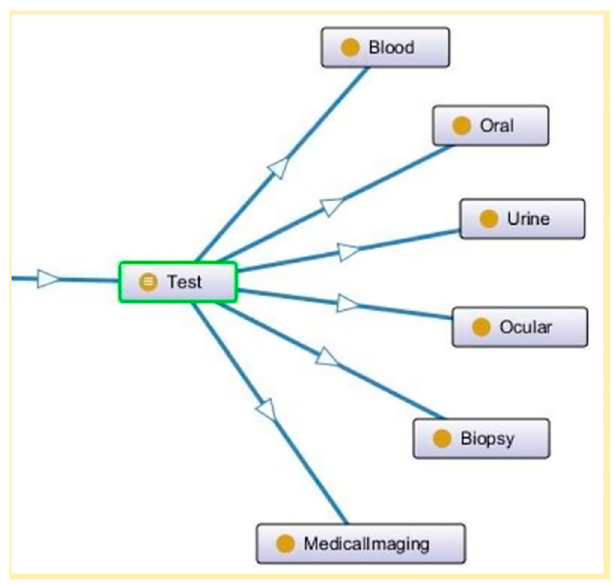
Figure 2. Test class hierarchy.